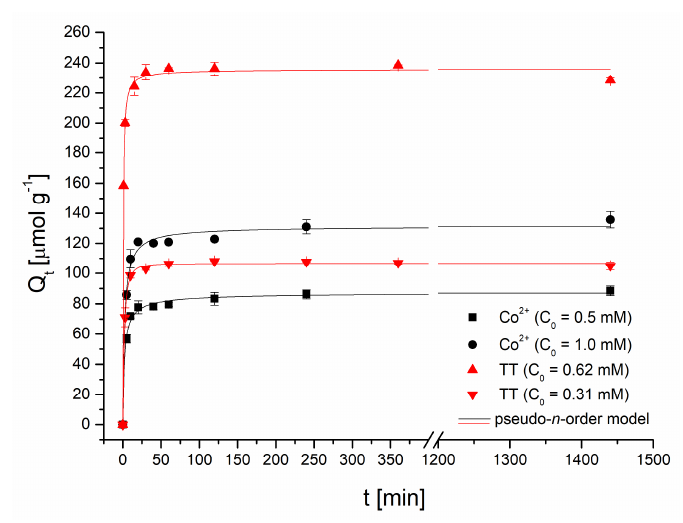
Figure 5. E ff ect of the reaction time on Co 2 + and thioflavin T adsorption by magnetically responsive Figure 5. Effect of the reaction time on Co 2+ and thioflavin T adsorption by magnetically responsive